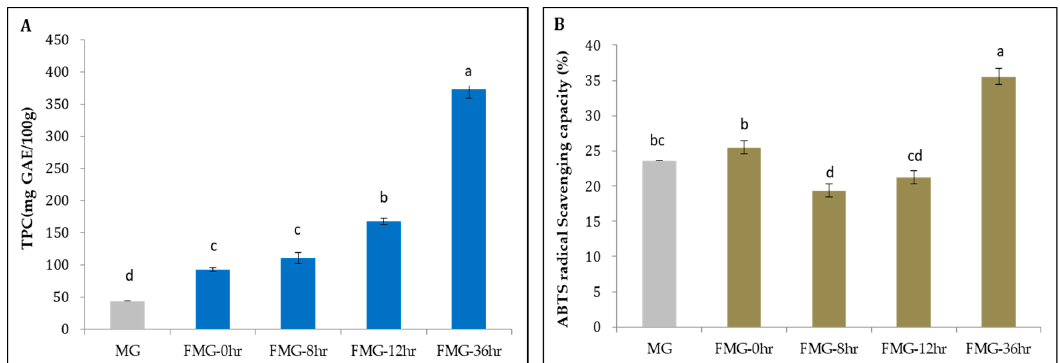
Figure 5. The contents and activities of antioxidant during MG fermentation. ( A ) Total Phenolic Content (TPC) and ( B ) ABTS+ radical scavenging capacity during fermentation. MG, a grain mixture before steaming; FMG-0hr, a mixture of grain steamed for 30 min at 100 °C; FMG-8hr, a mixture of grain fermented for 8 h; FMG-12hr, a mixture of grain fermented for 12 h; and FMG-36hr, a mixture of grain fermented for 36 h. Data from one representative experiment of three independent experiments were presented as the mean with standard deviation of three technical replicates. Values with different letters are significantly different with p < 0.05 according to Duncan’s multiple-comparison test. GAE: gallic acid equivalent.